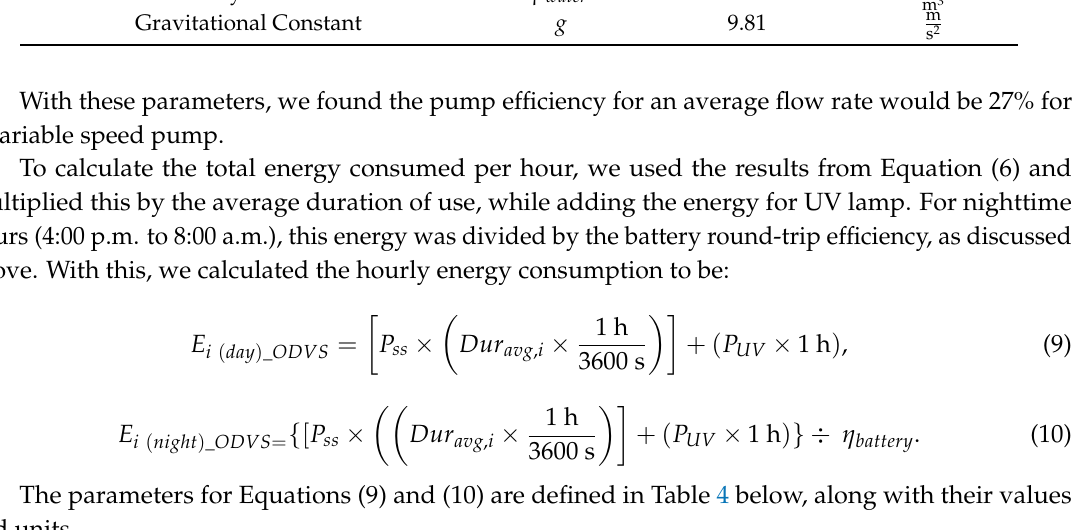
Table 4. Parameters for Equations (9) and (10) specifying parameter, symbol used, value and units used. Parameter Symbol Value Unit Pump Steady State Power per Hour P ss Determined from Equation